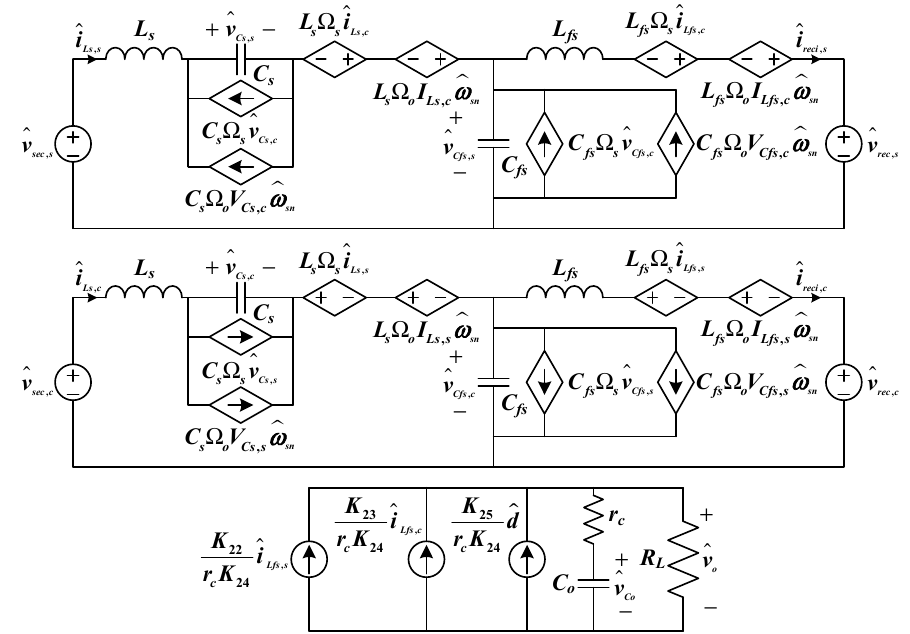
Figure 7. Linearized small-signal equivalent circuit of double-sided LCC compensation topology with S-BAR.